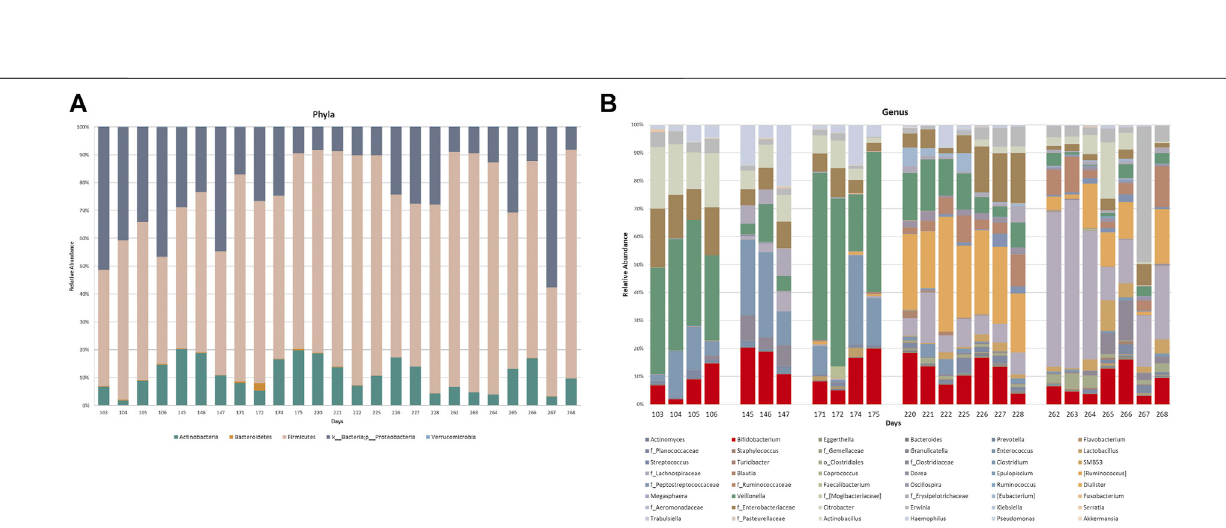
Frontiers in Molecular Biosciences |